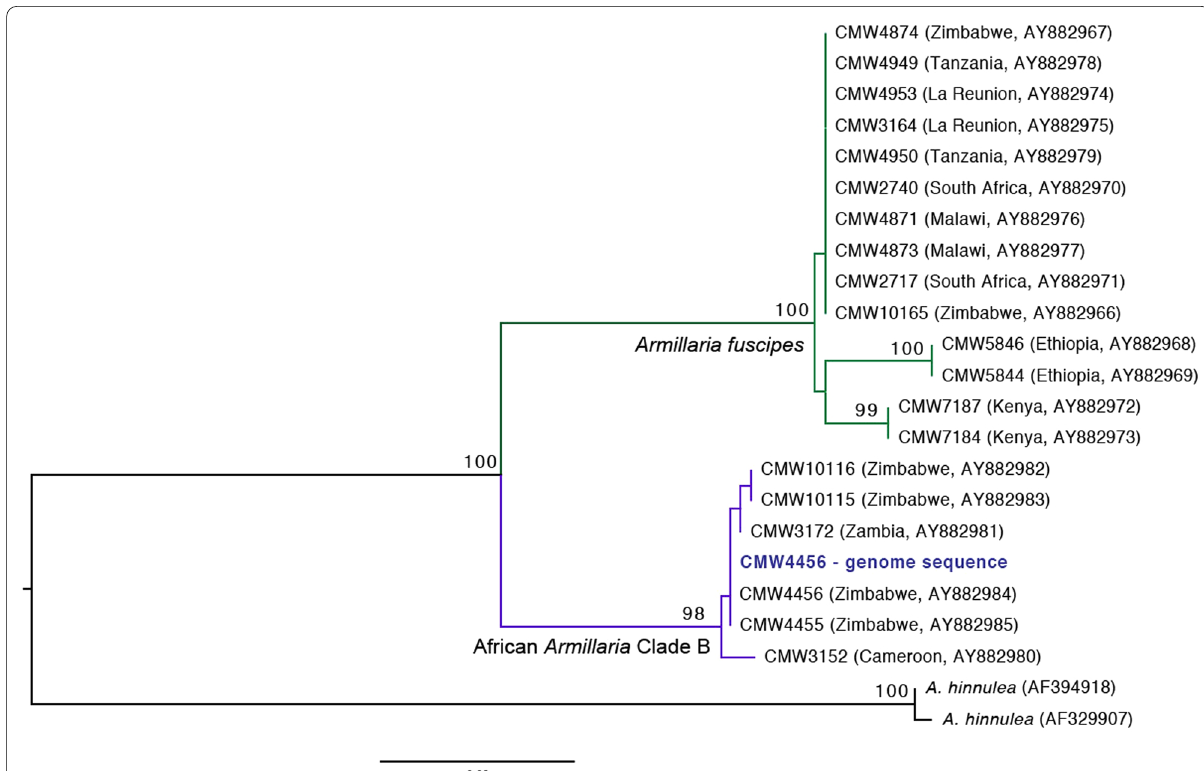
Fig. 1 Maximum likelihood tree based on ITS sequence data, confirming the identity of the Armillaria African Clade B sp. strain CMW4456 sequenced in this study (highlighted in bold). Bootstrap values above 80% are shown above the nodes. The scale bar represents nucleotide substitutions per